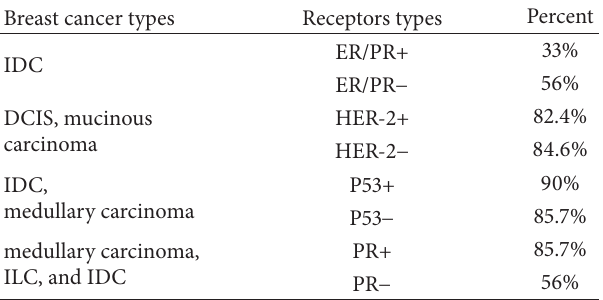
Table 1: Frequency of hormone receptors and breast cancer